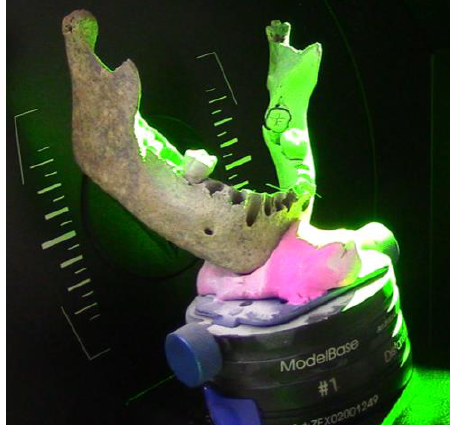
Figure 6. Scanning of palaeoanthropological